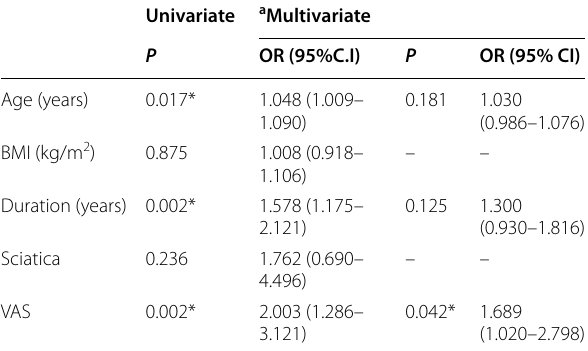
B: Unstandardized coefficients, r: Pearson coefficient, R 2 Coefficient of determination CI confidence